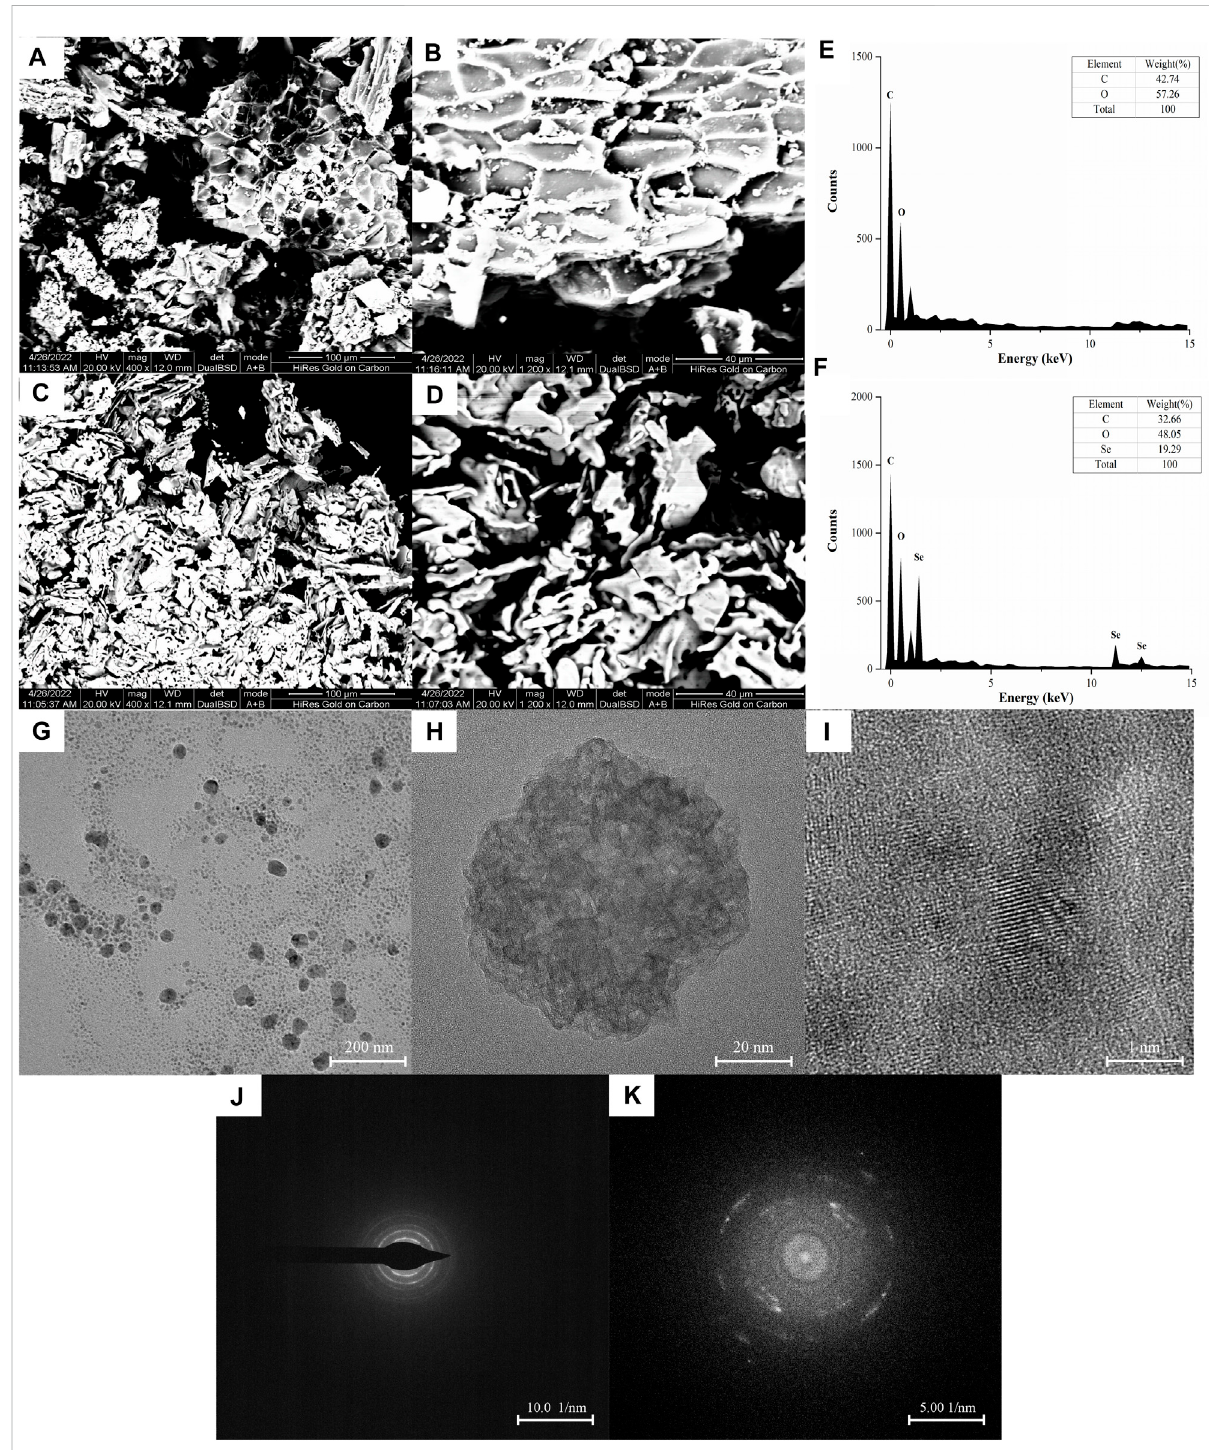
SEM images of (A,B) BRP and (C,D) BRP-SeNPs, A and C under ×400 magni fi cation, B and D under 1200 × magni fi cation. The distribution of C, O, and Se in (E) BRP and (F) BRP-SeNP by EDX analysis. Representative (G) TEM and (H,I) HRTEM images of BRP-SeNPs and its corresponding (J,K) SAED